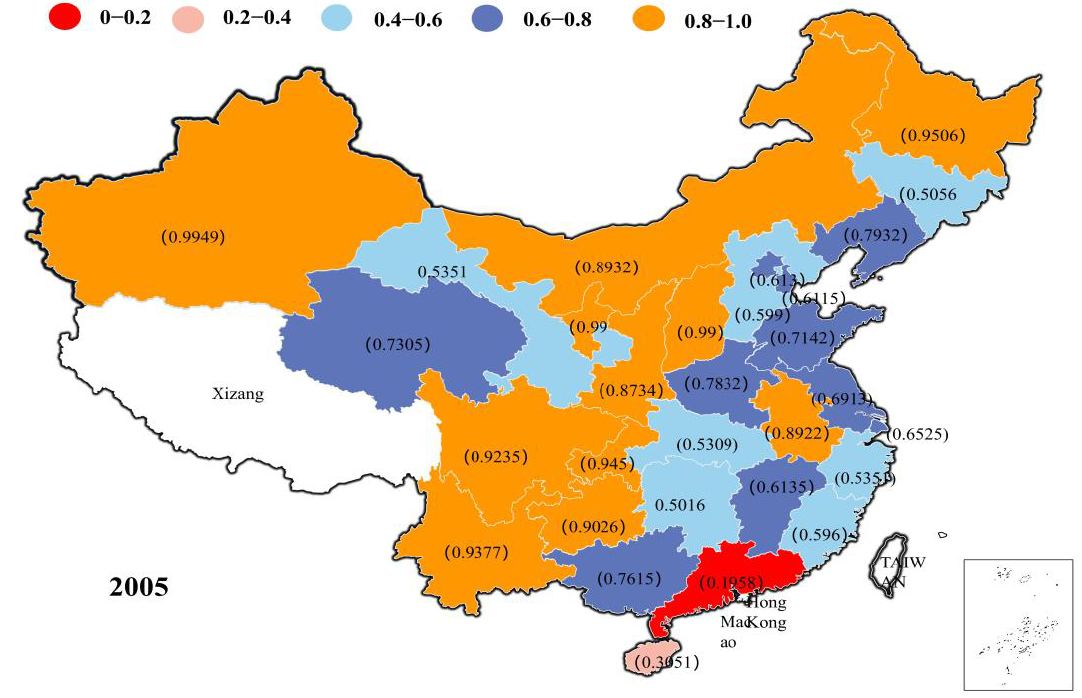
Figure 7. Spatial patterns of CERI scores in 2005 in 30 Chinese provinces.